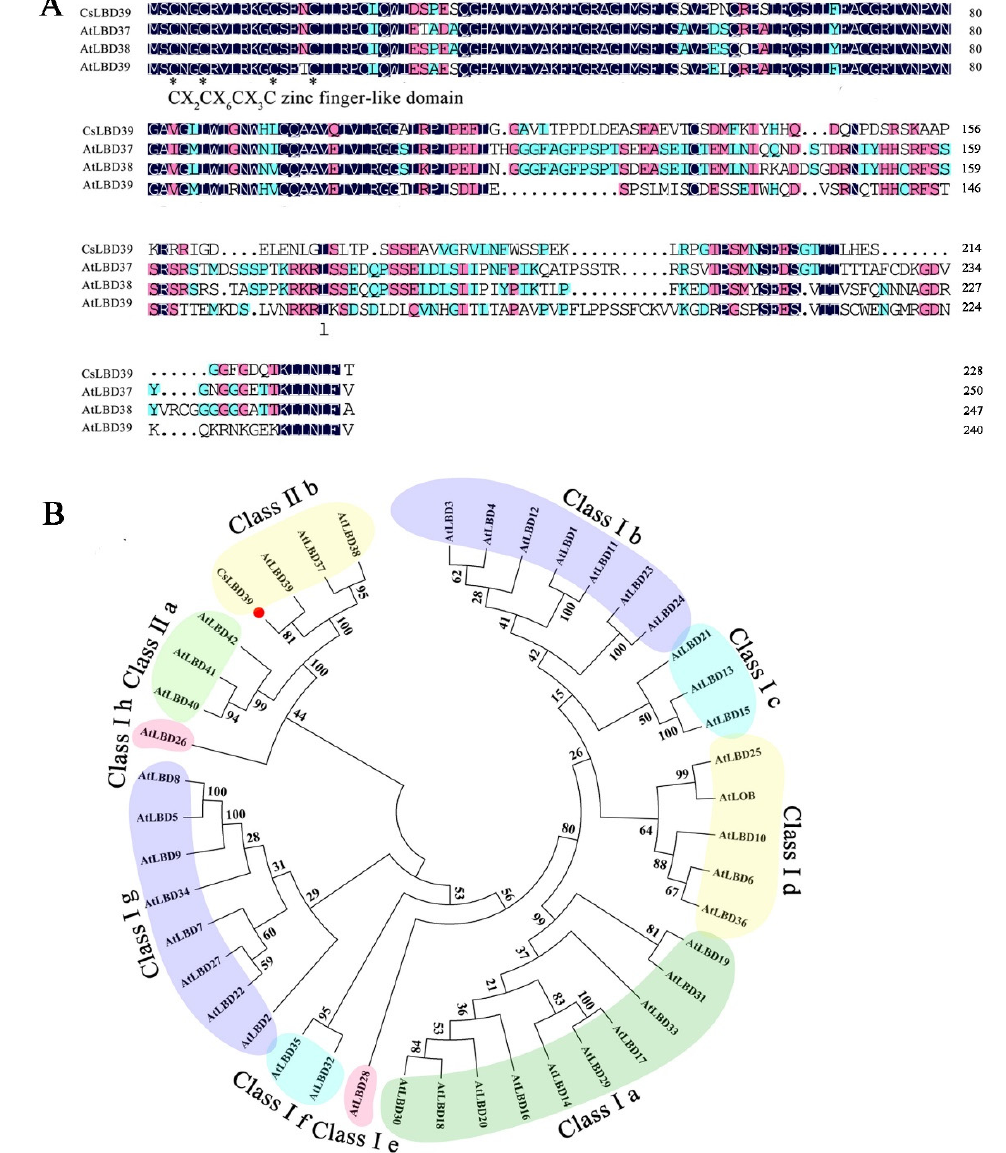
Figure 1. Bioinformatics analysis of the CsLBD39 protein sequence. ( A ) Multiple sequence alignments among CsLBD39 and other LBDs from Arabidopsis . The conserved DNA-binding domain is indicated by black asterisk. ( B ) Phylogenetic tree of CsLBD39 and AtLBDs from Arabidopsis . Red circle represented CsLBD39.